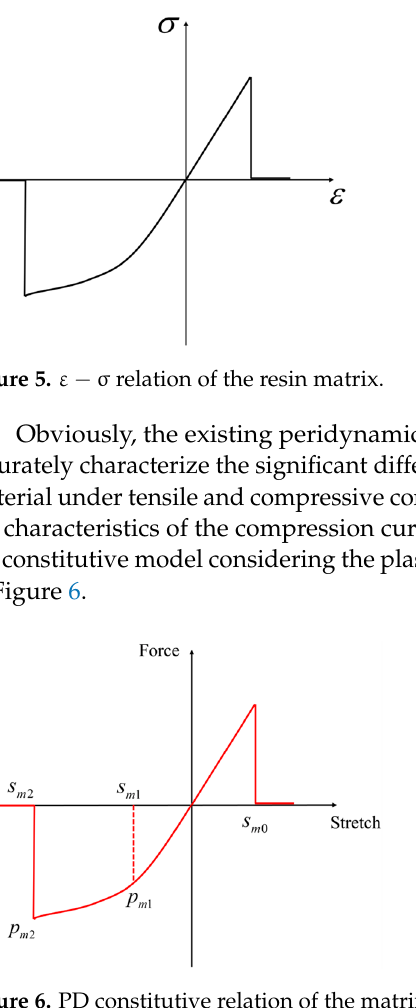
Figure 4. PD constitutive relation of the fiber bond.